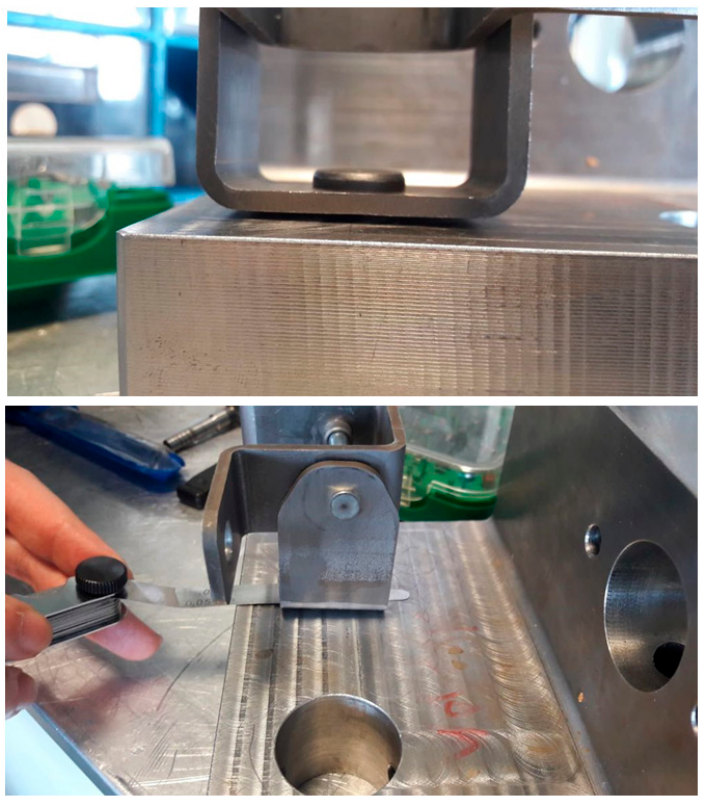
Figure 12. Gap evaluation of dummy door hinge on test apparatus with 0.05 feeler gauge. Friction